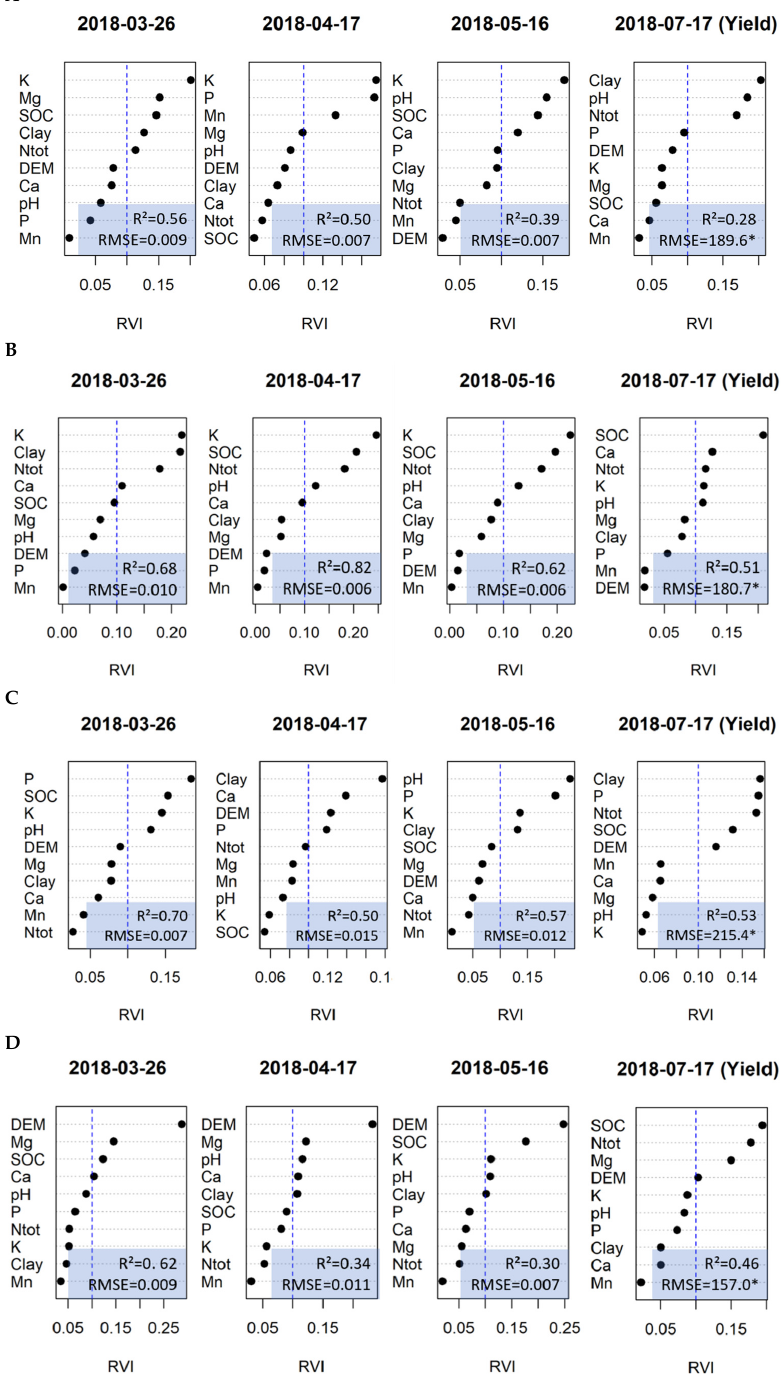
Figure A3. Relative variable importance (RVI) of predictor variables (variable importance of a given variable normalized to the sum of variable importance of all variables in the model) influential to crop growth at four dates during the growing season of the winter wheat crop in 2018 for each of the four former parcels ( A – D ) of the former field layout (see Figure 1), calculated by conditional inference forest algorithm after the removal of correlated variables. The vertical dashed line indicates the expected importance in a completely random model. The performance of the models was evaluated using the R 2 and RMSE throughout the winter wheat growing season and the harvest. * Expressed in kg ha − 1